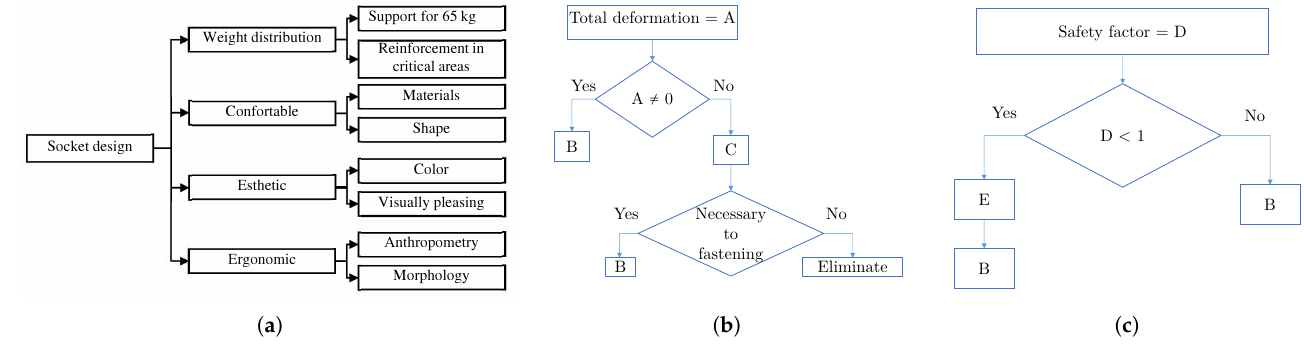
Figure 3. Features for socket design: ( a ) elements to consider for socket design; ( b ) methodology for surface treatment; and ( c ) methodology for insert